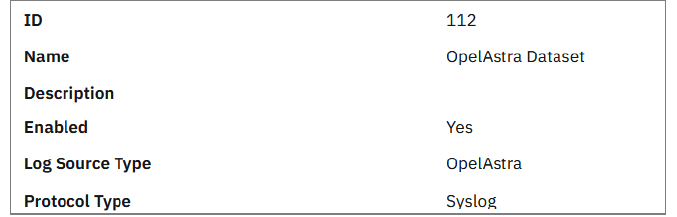
Figure 2. Log source created to receive the CAN messages.